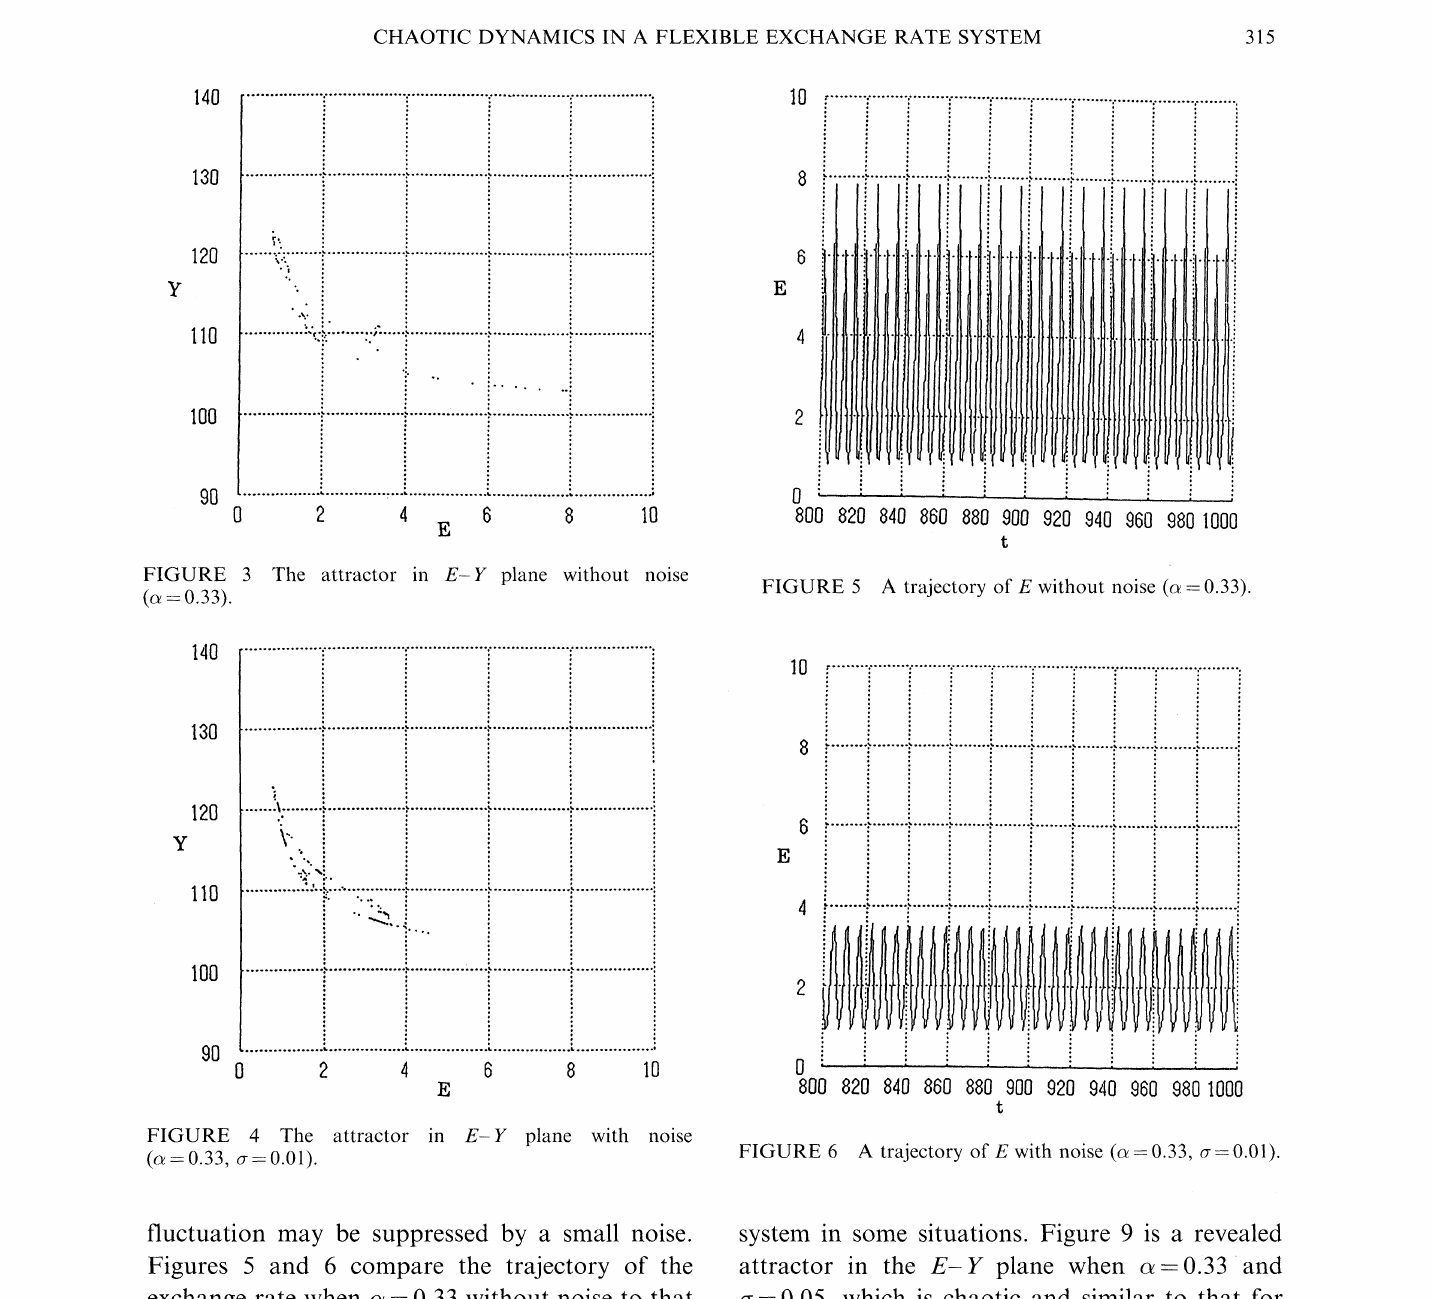
FIGURE 5 A trajectory of E without noise (c 0.33).